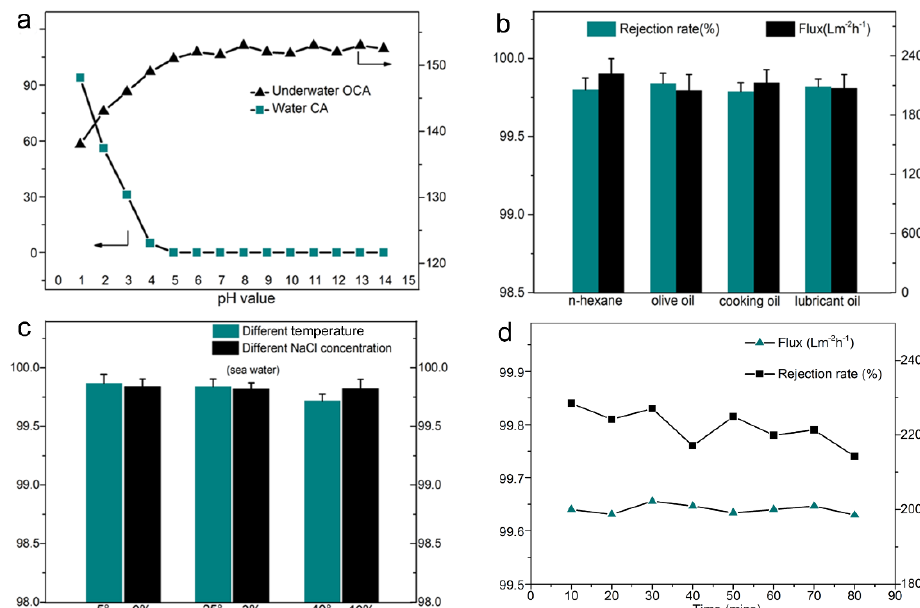
Figure 7. The oil/water mixture separation process: ( a ) the water CA and underwater oil CA under different pH value conditions; ( b ) the rejection rate and flux of different oil/water mixtures; ( c ) the rejection rate under different penetrating temperature and NaCl concentration (olive oil as the model oil); ( d ) the rejection rate and flux under 80 min (olive oil as the model oil).